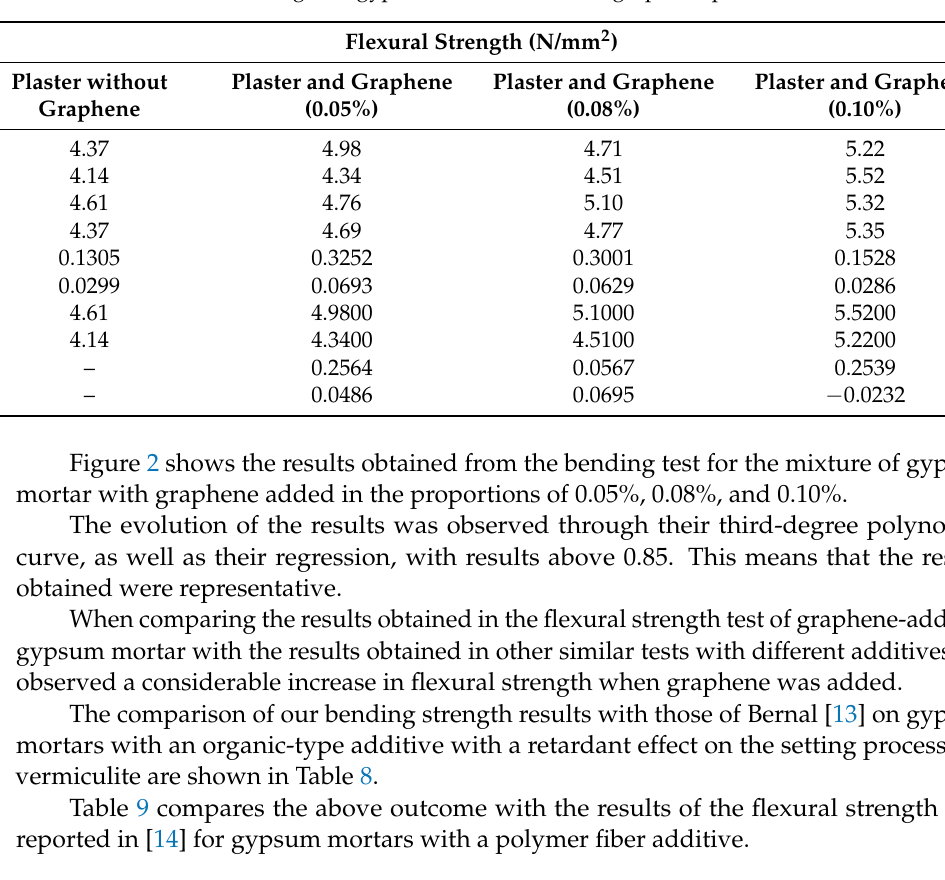
Table 7. Test results for the flexural strength of gypsum mortar with add graphene